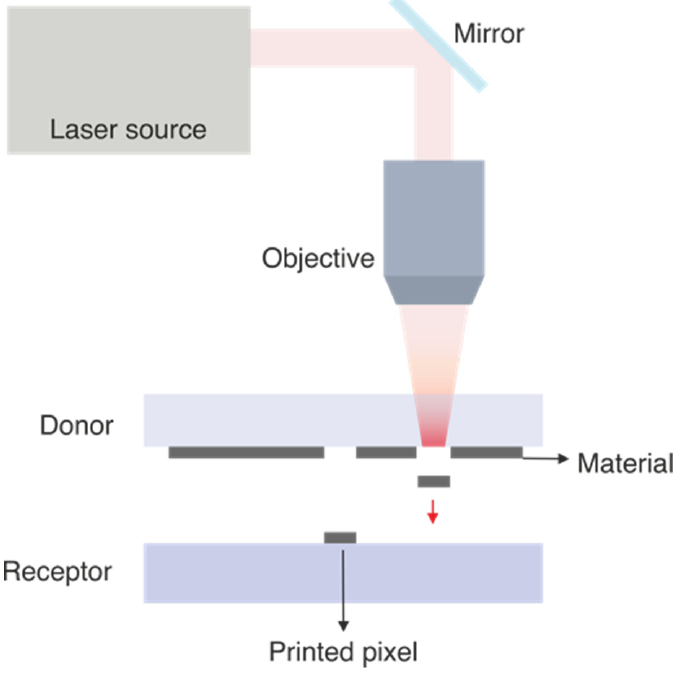
Figure 1. Sketch (not to scale) that includes the main elements of an experimental setup to print materials via LIFT.